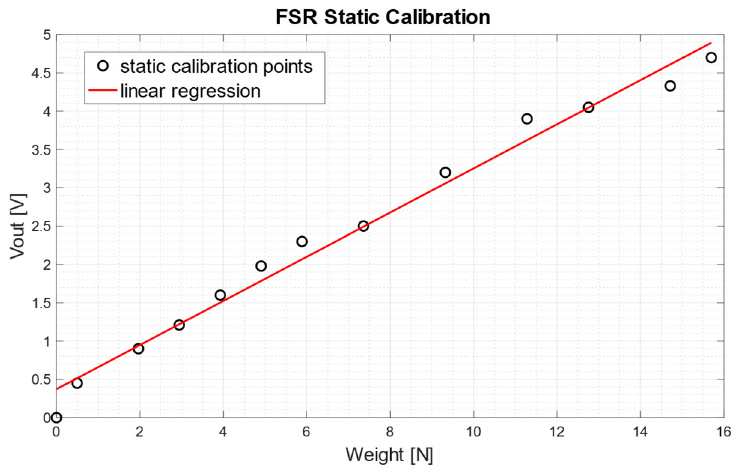
Figure 10. FSR-based sensor static calibration: scatter plot of the experimental data (o) and regres- sion line.